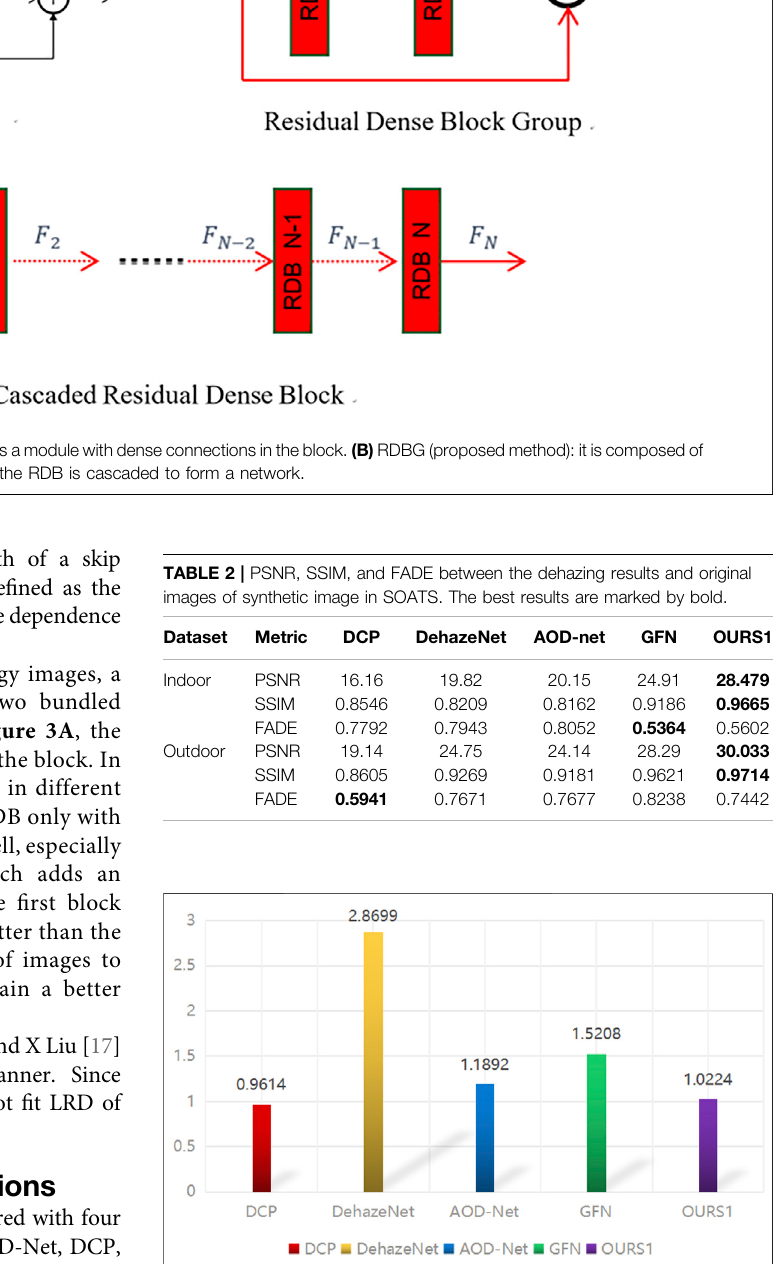
FIGURE 4 | Average FADE of test results of different algorithms in real fog images collected in SOAT and the Internet.